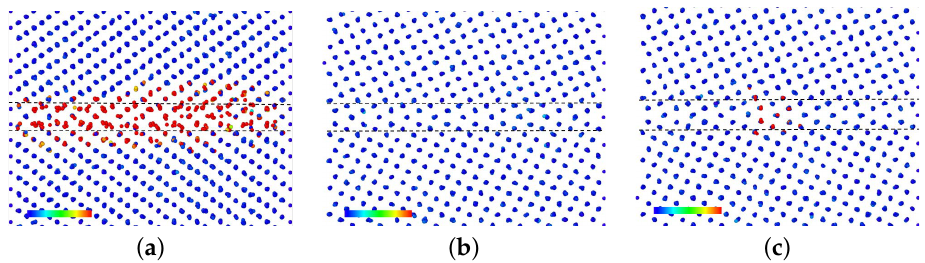
Figure 2. The behavior of Fe atoms at 600 K for ( a ) Σ 3 GB, ( b ) Σ 5 GB, and ( c ) the case of Σ 5 GB with a vacancy: Each figure shows the atomic state at 0.5 µ s. The dashed lines are the boundaries of the initial GB region. The color legend represents the migration distance; the red color means the migration of more than one lattice